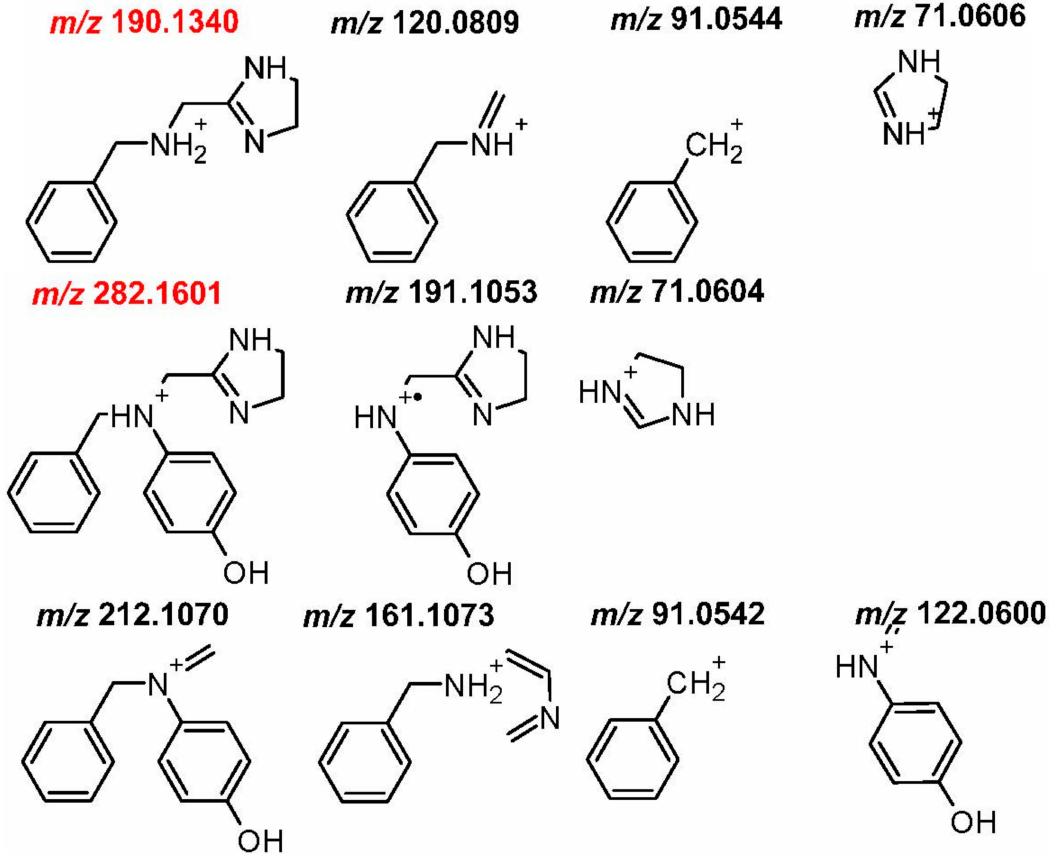
Figure 3. Monoisotopic mass of protonated molecular ion (M + H + ) of the main ANT Phase I metabolites: M1 ( m / z 190.1340) and M2 ( m / z 282.1601) and their fragment ions obtained with a normalized collision energy of 20, 35, 50 eV using Orbitrap Focus. Pseudo-molecular ions of M1 and M2 were marked in red.